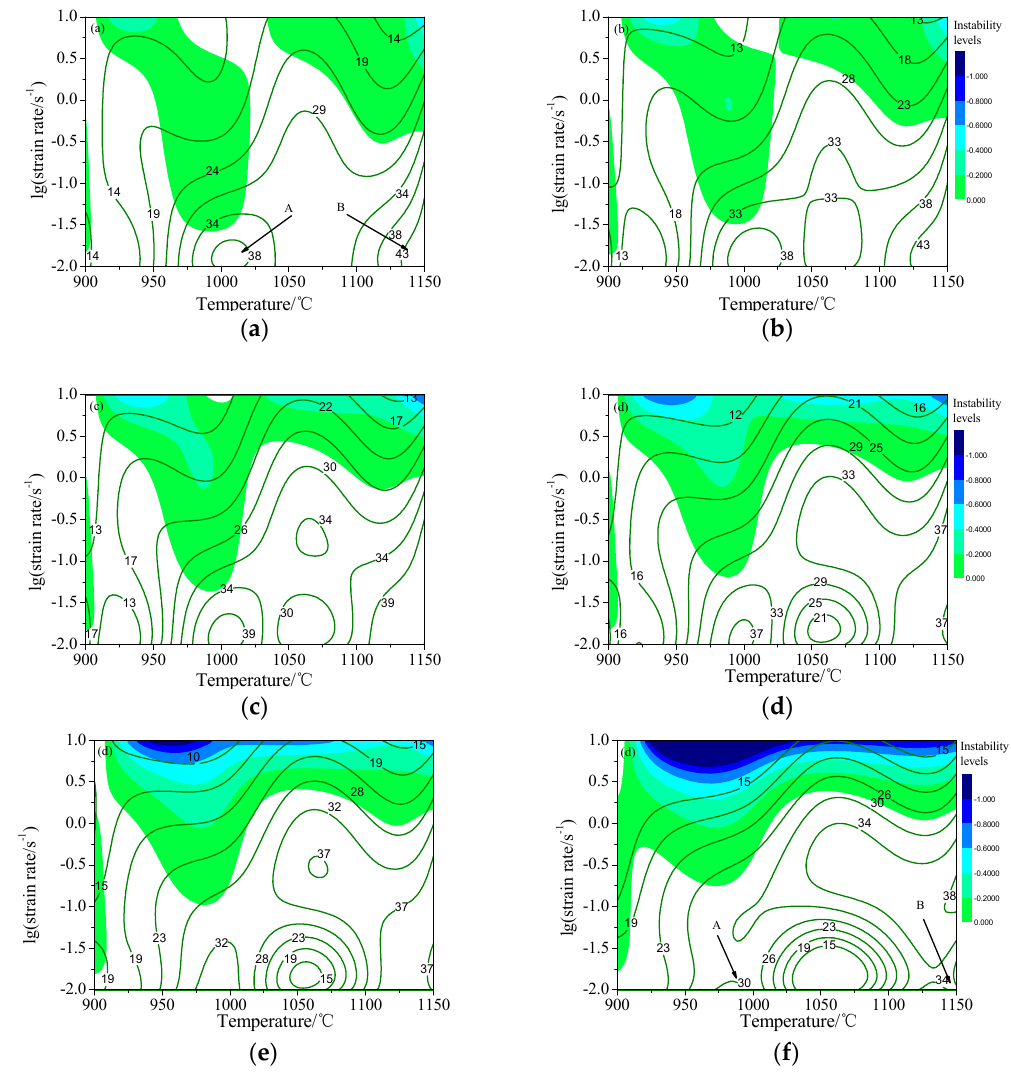
Figure 9. Processing maps for the H13-mod steel at true strains of ( a ) 0.4, ( b ) 0.5, ( c ) 0.6, ( d ) 0.7, ( e ) 0.8, and ( f ) 0.9.